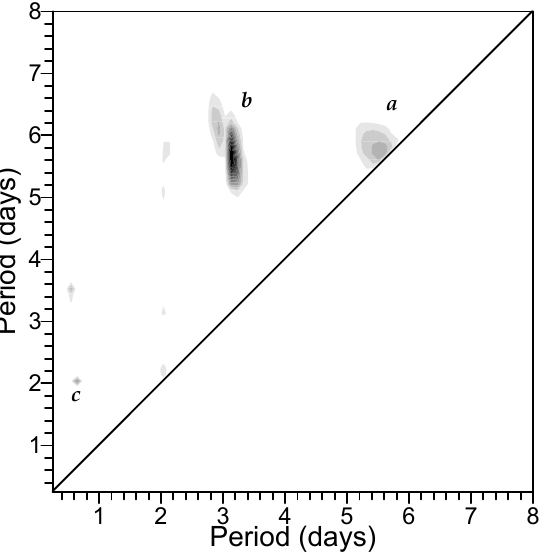
Fig. 9. Magnitude of the bispectrum squared of the UK meridional wind data. Only the top left half of the quadrant is plotted because the bispectrum is symmetrical about a